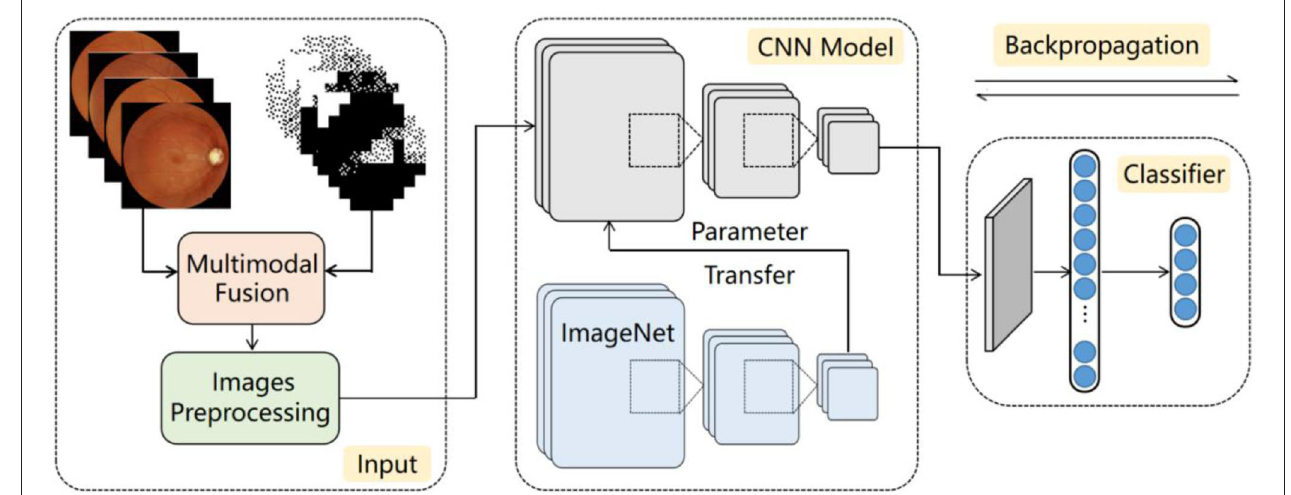
FIGURE 1 | Diagram of proposed architecture.